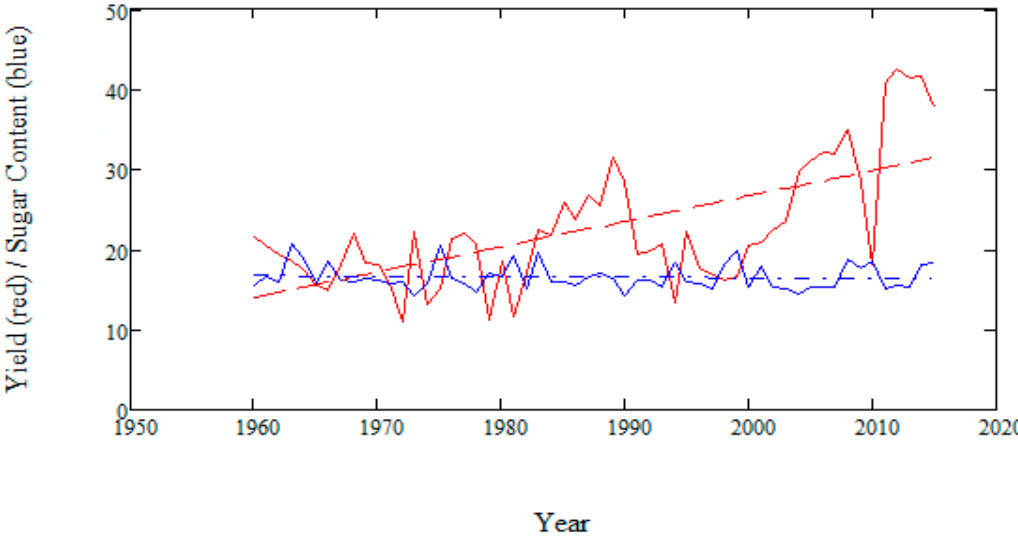
Figure 6. The Belgorod Region sugar beet yield (red - tons ha − 1 ) and sugar content (blue - %). The linear regression (trend) models are also shown, where the red line is sugar beet yield (tons ha − 1 ) and the blue line is sugar content (%).